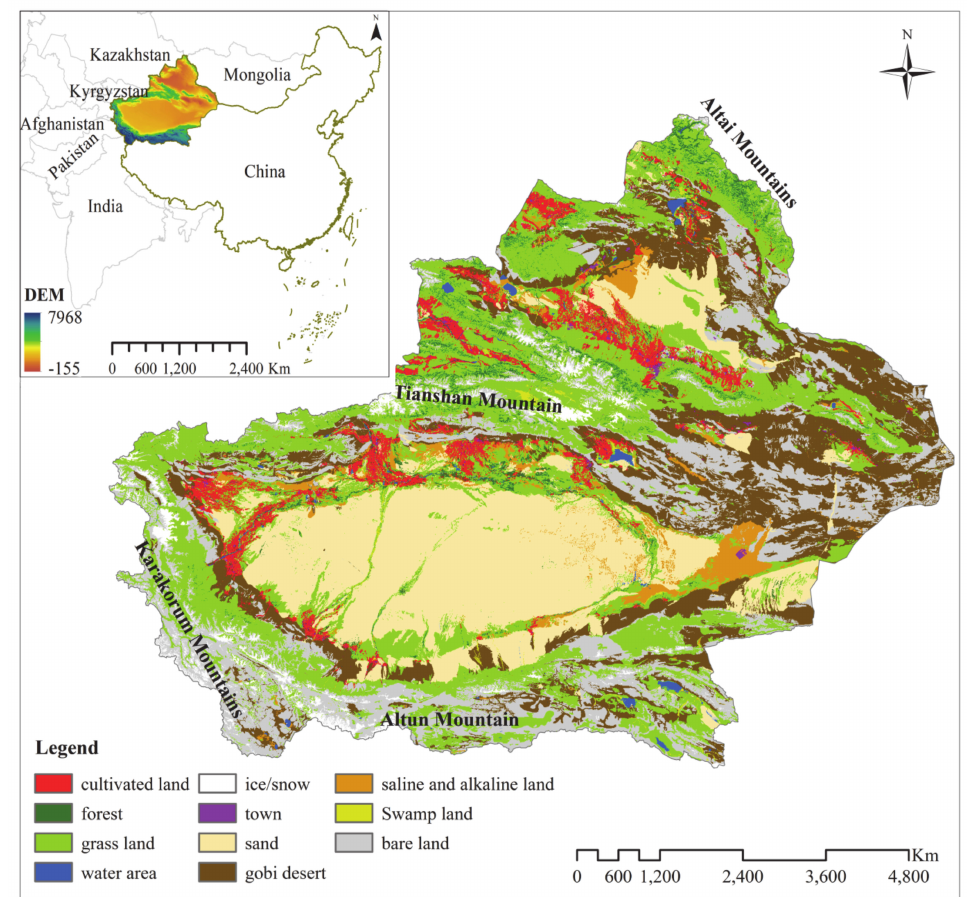
Figure 1. Xinjiang region geographical location, topography, and land use: geographical location data from standard map website (Review picture serial number: GS(2019)3266), The DEM data are from USGS, and the land use types are abbreviated from the vegetation type map of China at a scale of